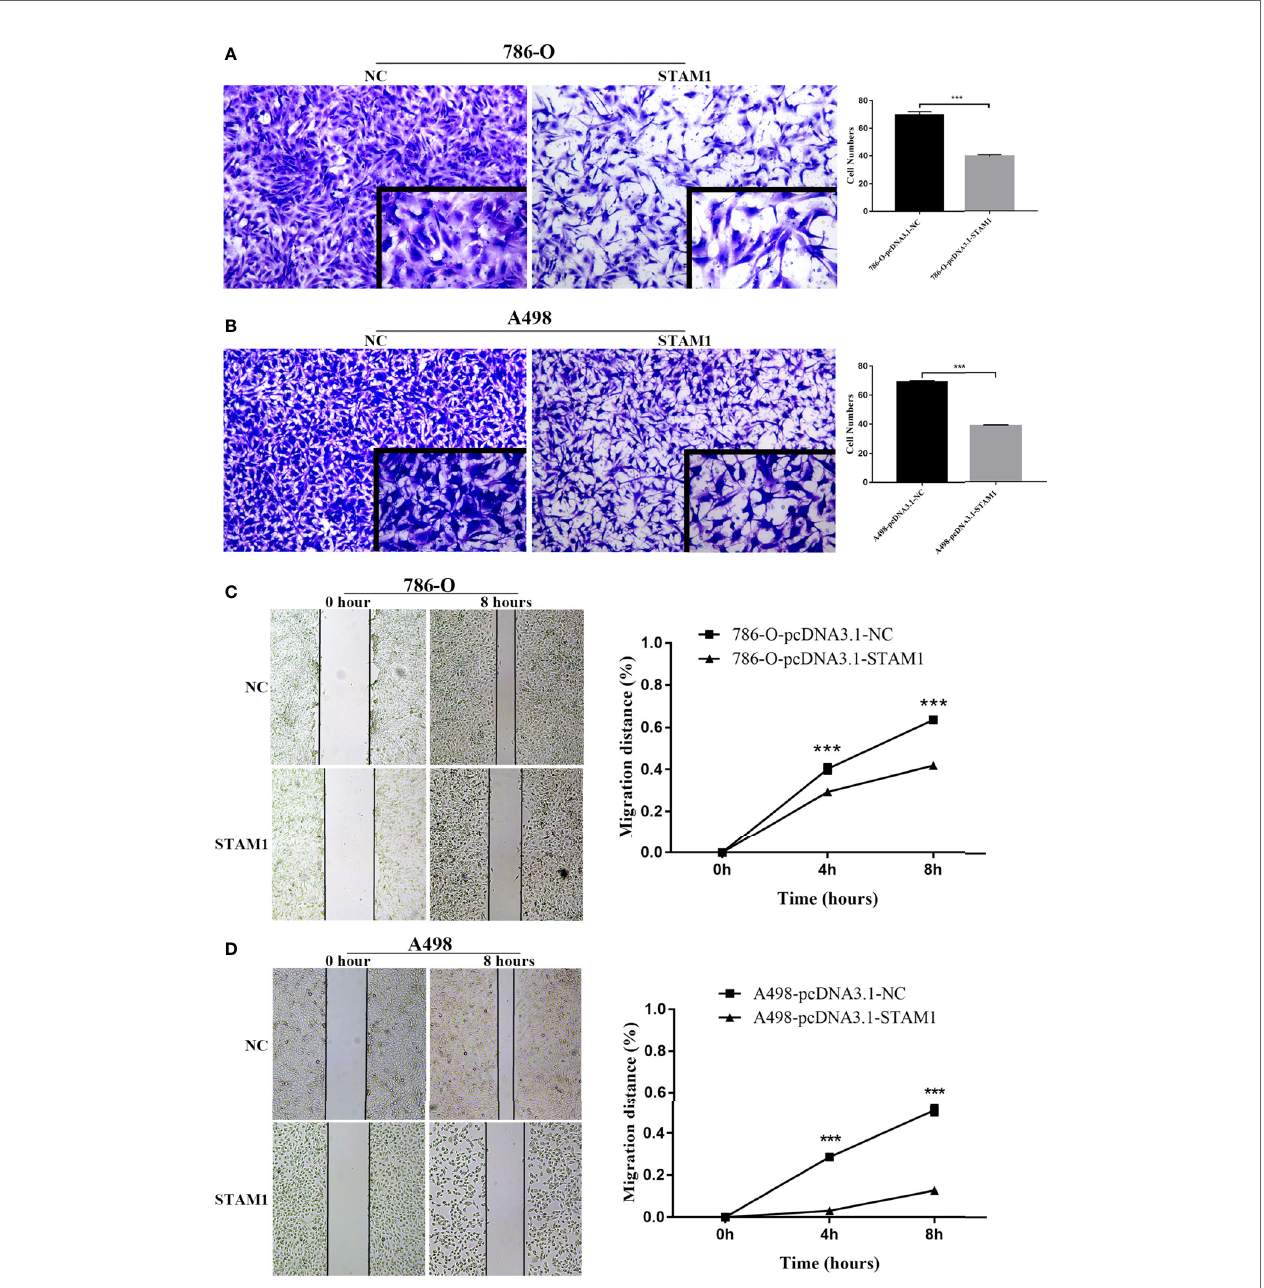
FIGURE 7 | Invasion and migration capability assessment after overexpressing STAM1 in 786-O and A498 cells. The invasion capability of 786-O (A) and A498 (B) cells was determined using the Matrigel transwell invasion assay. At 24 h later, the cells that had passed though the membrane were calculated and compared to baseline levels. The motility of 786-O (C) and A498 (D) cells was detected by the wound-healing assay. Migration distances compared to baseline were measured after 4 and 8 h. *** p <